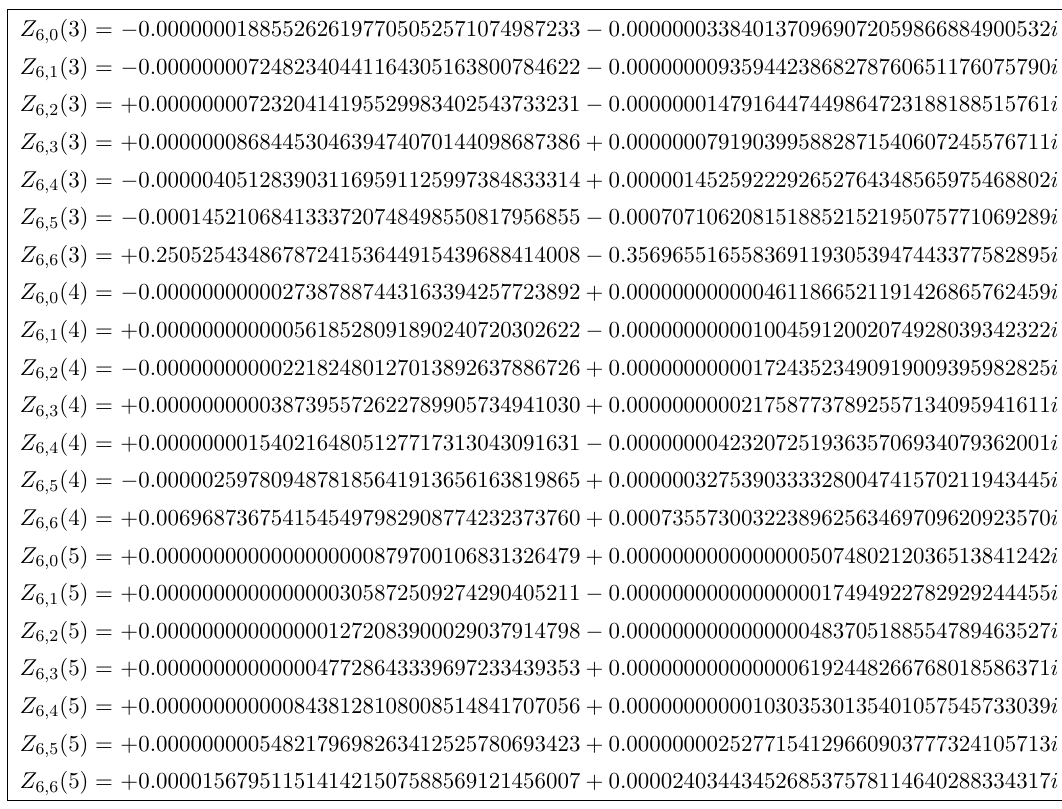
Table 3 . Exact values of Z k,M ( N, m 1 , m 2 ) for a generic complex value of m 1 = m 2 which we √ √ have chosen as m 1 = m 2 = ( 2 + 3 i ) / 2 . Together with the exact values of Z k,M ( N, m 1 , m 2 ) for N = 1 , 2 in appendix B.1, the displayed digits of the numerical values of Z k,M ( N, m 1 , m 2 ) for N ≥ 3 are sufficient for checking the bilinear relation (3.1) at order ∼ 10 − 35 which is smaller than the values of Z k,M ( N, m 1 , m 2 )